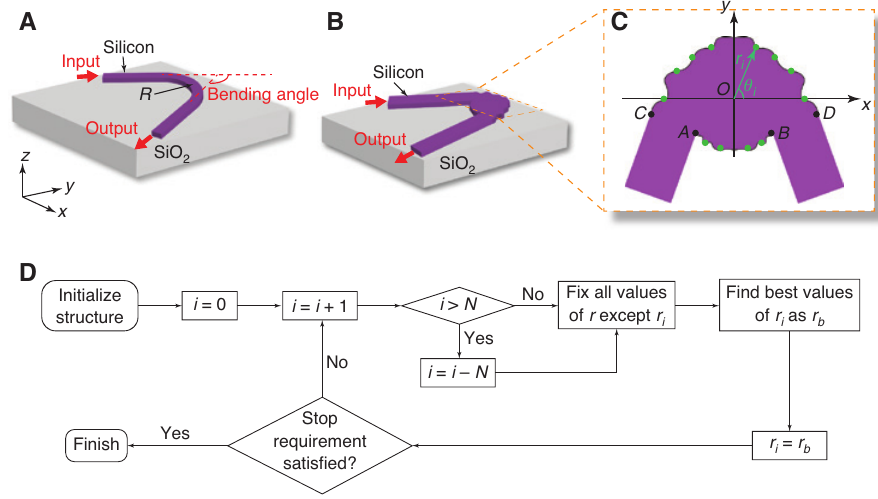
Figure 1: Conventional and new schemes for turning the direction of light flow on a chip. (A) Schematic of the conventional waveguide bend for connecting two nonparallel waveguides. R is the inner radius of the waveguide bend, which should be at least tens of micrometers to avoid significant modal mismatch and bending loss. The gray and purple regions represent SiO and Si, respectively. (B) Schematic of the photonic welding point for connecting two nonparallel waveguides. (C) Top view of the 2 photonic welding point, the structure of which is defined by two continuous lines AB and CD going through the green dots. (D) Algorithm flowchart for the optimization